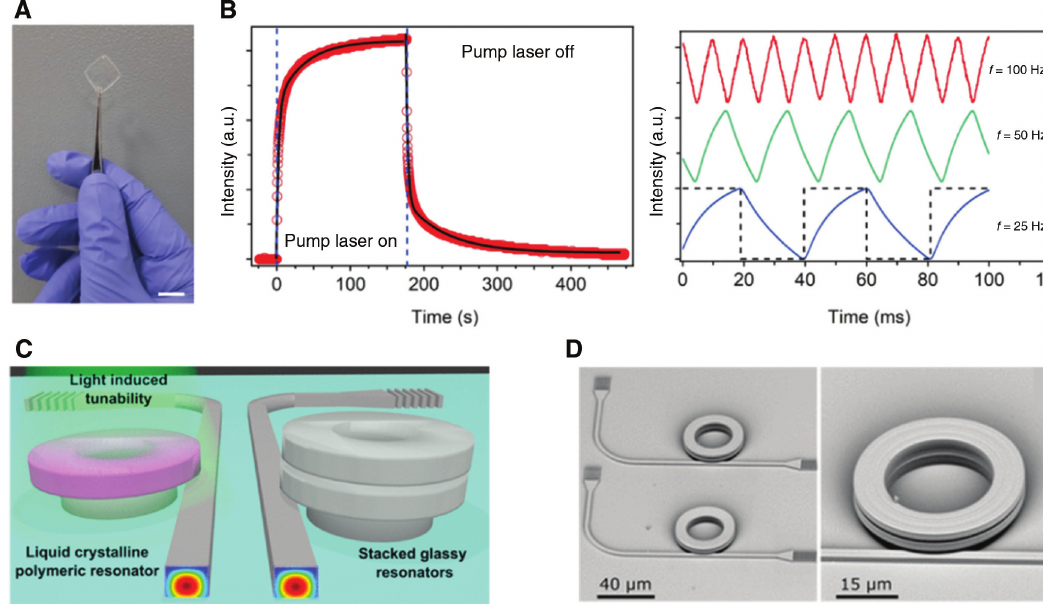
Figure 10: 4D printing of photoresponsive materials. (A) Photograph of an optical window after polishing (scale bar: 1 mm). (B) The intensity value with the 532 nm pump laser on and off